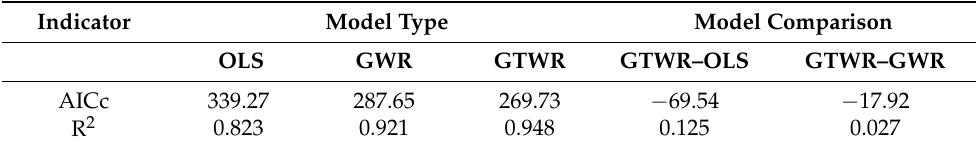
Figure 3. Spatial distribution of PM 2.5 concentrations in the Beijing–Tianjin–Hebei urban agglomera- tion from 2015 to 2019. Table 2. Assessment of GTWR